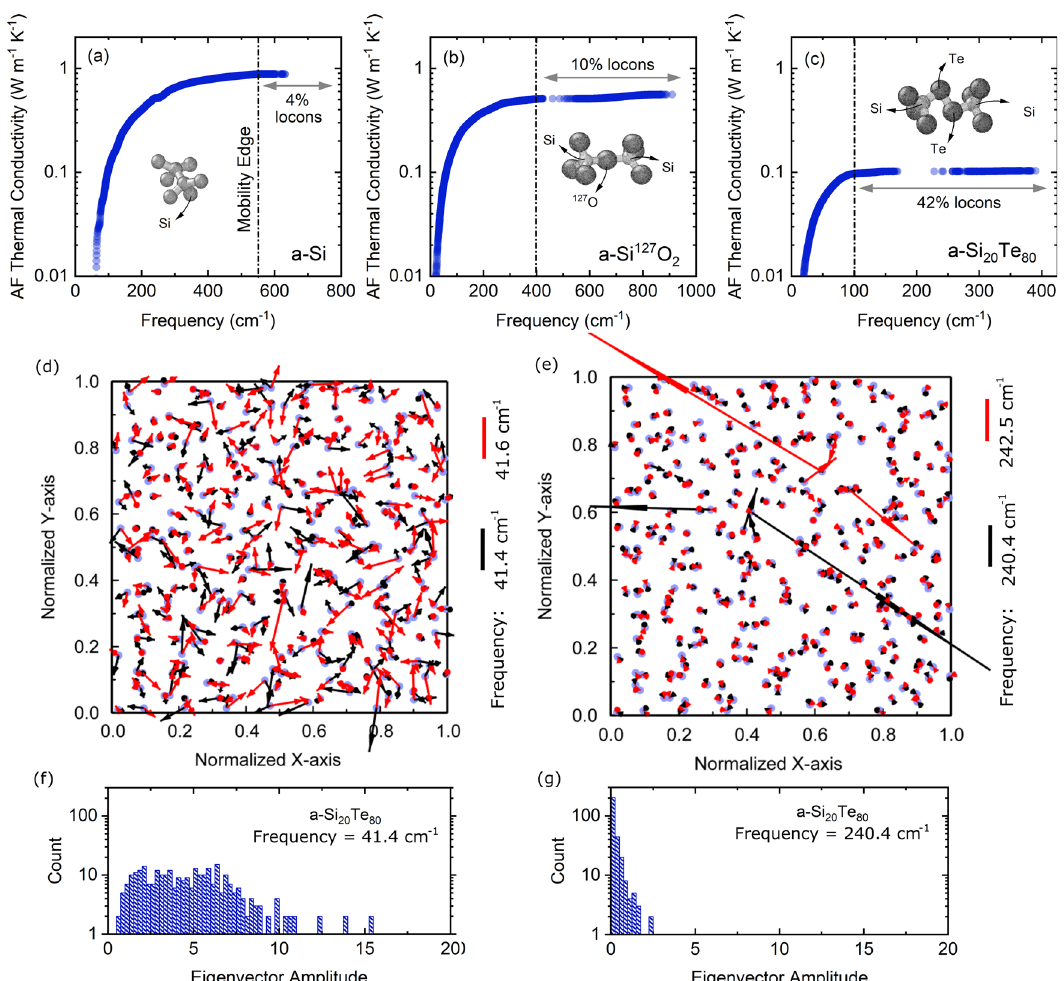
Fig. 4 Lattice dynamics predictions for diffuson thermal conductivity and visualization of localization effects. Allen – Feldman thermal conductivity accumulation as a function of vibrational modes frequency for a amorphous silicon, a -Si, with inset showing Si-Si bond between two tetrahedrons, b amorphous silicon heavy-oxide, a -Si 127 O 2 , with inset showing Si- 127 O-Si bond between two tetrahedrons, and c amorphous silicon telluride, a -Si 20 Te 80 , with inset showing Si-Te-Te-Si bond between two tetrahedrons. Projection of eigenvectors associated with each mode on a xy -plane, indicating the degree of spatial and energetic overlap at two consecutive frequencies, d delocalized: 41.4 cm − 1 (black arrows) and 41.6 (red arrows) cm − 1 , and e localized: 240.4 cm − 1 (black arrows) and 242.5 (red arrows) cm − 1 in a -Si 20 Te 80 . The few high amplitude eigenvectors at localized frequencies are an indication of strong localization showing the energy associated with these modes is con fi ned in a small geometric region. f , e Histogram indicating the population of modes based on their eigenvector amplitude at delocalized and